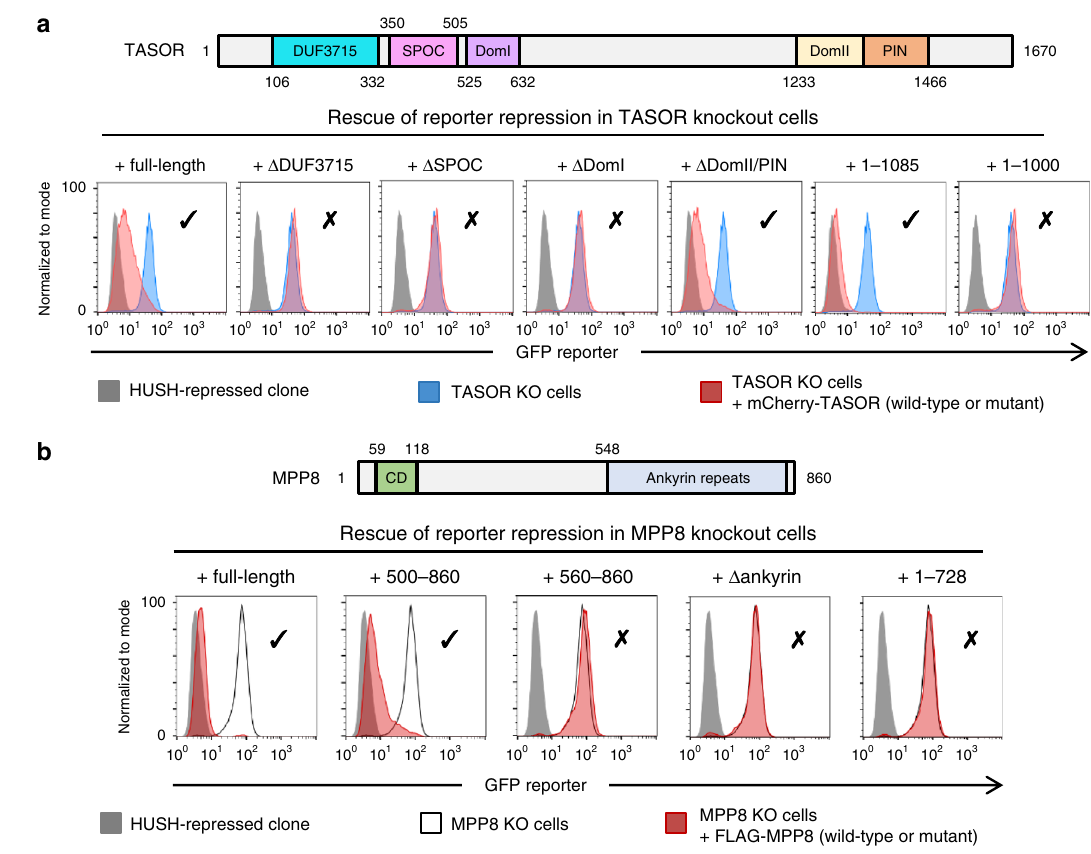
Fig. 2 Functional requirements of TASOR and MPP8 domains in HUSH transgene repression. a Genetic complementation of TASOR knockout cells. Exogenous expression of full-length TASOR or TASOR lacking the DomII/PIN domain restores GFP transgene repression as measured by fl ow cytometry, but mutants lacking the DUF3715, SPOC or DomI domains are non-functional. TASOR(1 – 1085) is functional and TASOR(1 – 1000) is non- functional. b Genetic complementation assays in MPP8 knockout cells demonstrate that the C-terminal ankyrin repeats are required for function, but the fi rst 499 residues are dispensable. Ticks and crosses indicate functionality in this